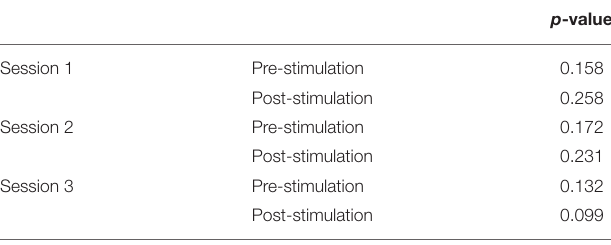
TABLE 2 | Results of the one-way ANOVAs comparing the initiation time of each scan between groups.